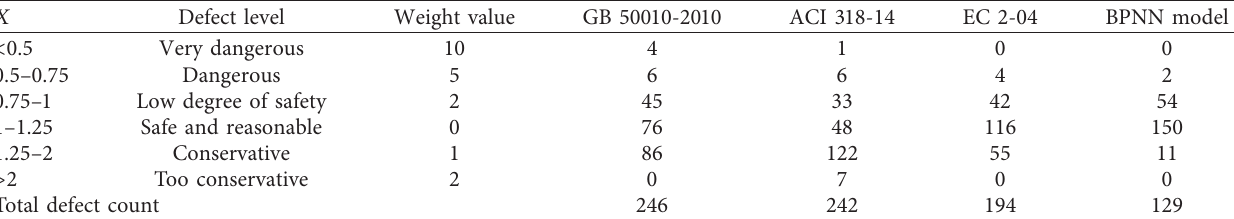
Table 4: Number of defect